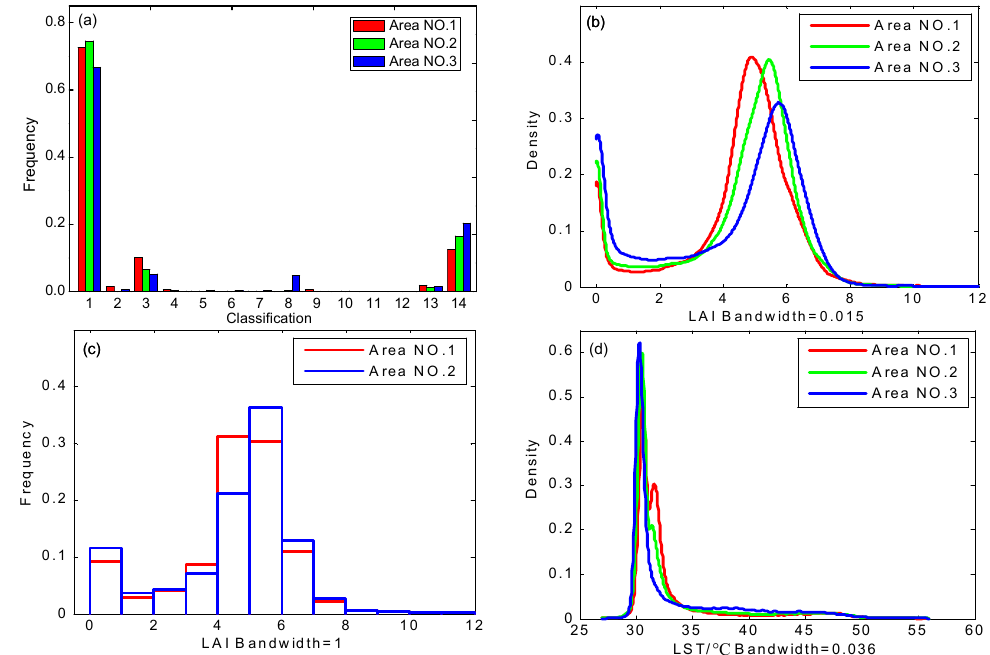
Figure 6. Probability density distribution and histogram of the surface variables and the surface types in three study areas: ( a ) histogram of 1-m classification data; ( b ) probability density distribution of LAI; ( c ) frequency distribution histograms of LAI (bandwidth = 1); and ( d ) probability density distribution of LST. Note: in the classification histogram, the values 1–14 represent maize, leeks, aspen, cauliflower, potato, lettuce, orchard, melon, beam, pear, peper, unclass, shadow and non-veg, respectively.